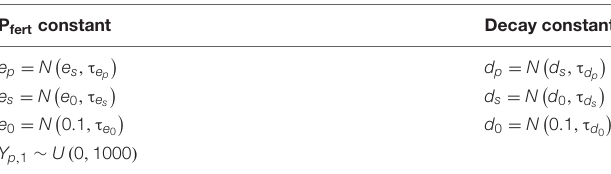
TABLE 2 | Assignment of priors to parameters e p and d p for a Bayesian model of soil P concentration change across six soils, each with a range of P init concentrations and P ferts